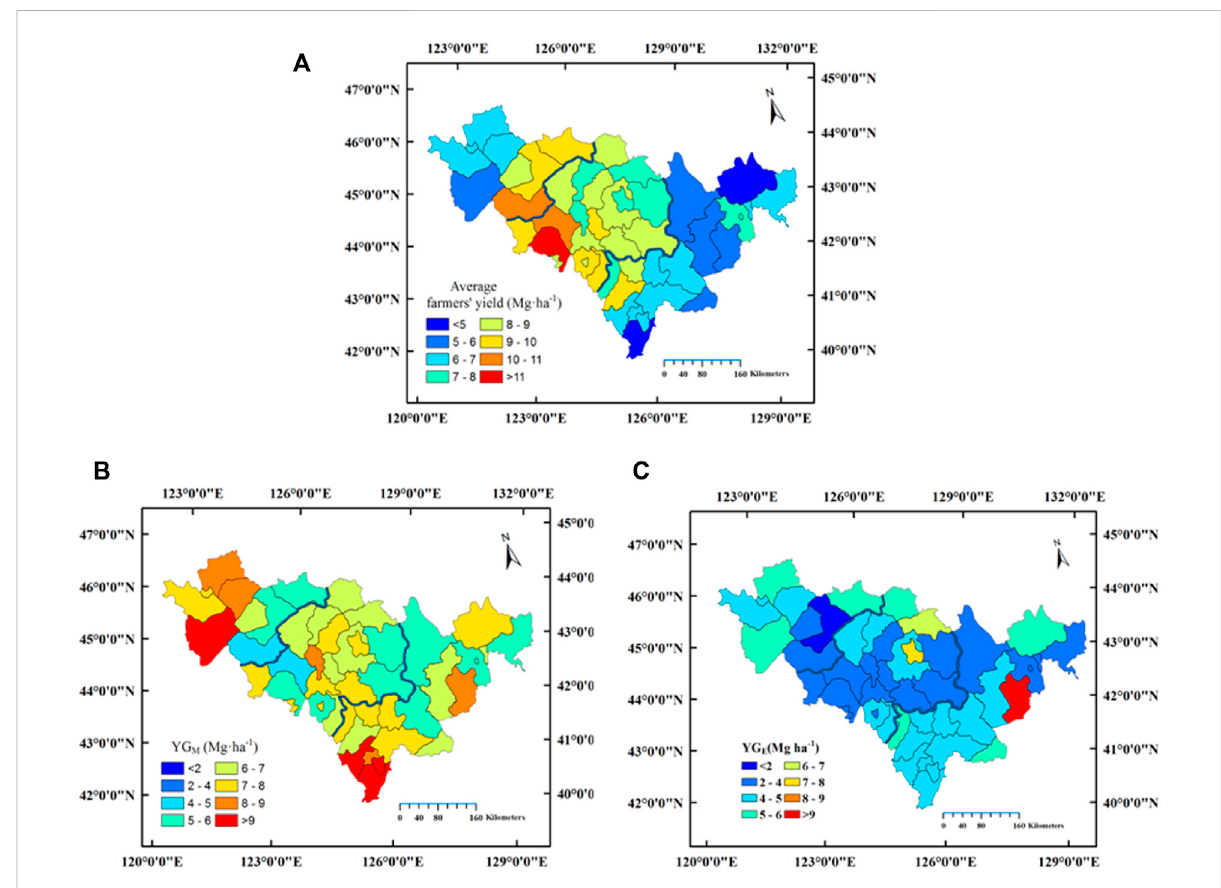
FIGURE 4 Spatial distribution of actual farms ’ yield (A) , YG M (B) , and YG E (C) for Jilin province. YG M was estimated as the difference between the modeled yieldpotentialandaveragefarmers ’